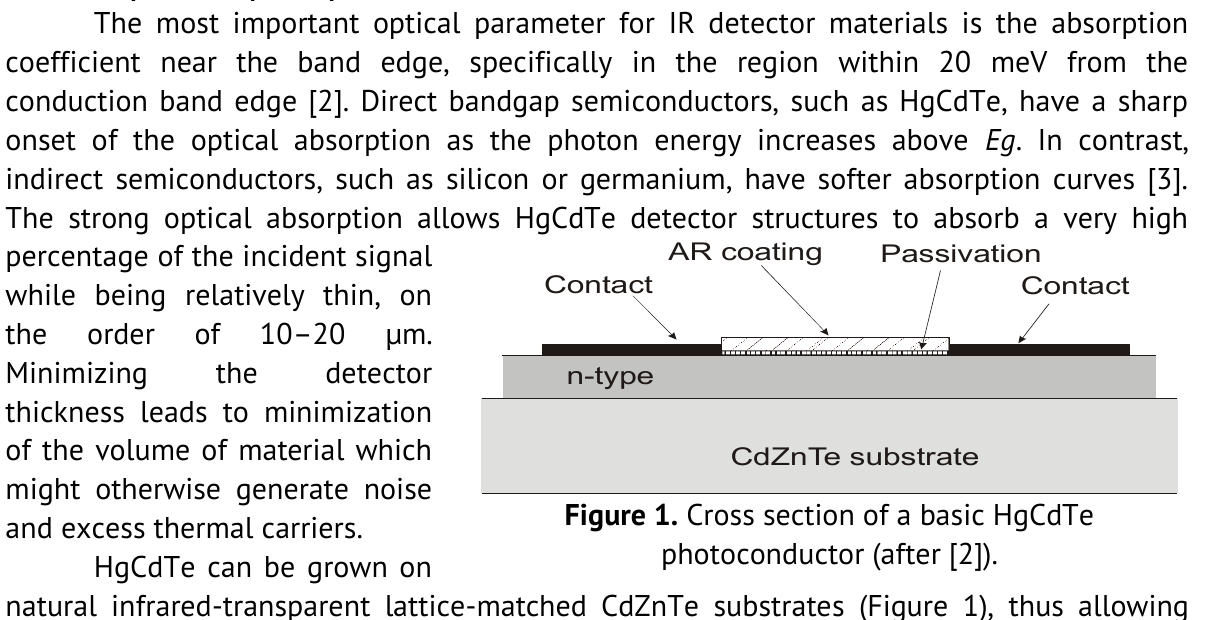
Figure 1. Cross section of a basic HgCdTe photoconductor (after